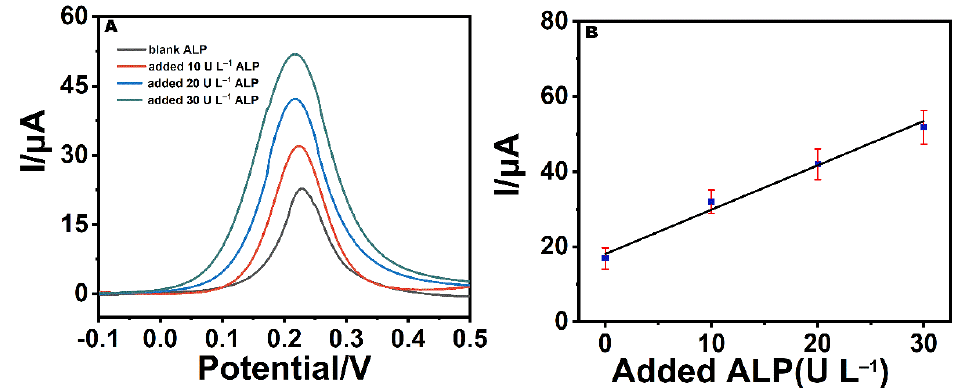
Figure 9. DPVs of various ALP concentrations (blank ALP, added 10 U L –1 ALP, added 20 U L –1 ALP, added 30 U L –1 ALP) for the AuNP/PEDOT:PSS-modified GCE in human serum (pH 9.0) containing 4 mg mL –1 1-naphthyl phosphate and 1 mM AgNO 3 ( A ), and the corresponding calibration plot ( B ). Error bars represent the standard deviation. Table 2. Results of the calculated and known concentrations of ALP spiked in human serum (n = 5). Sample